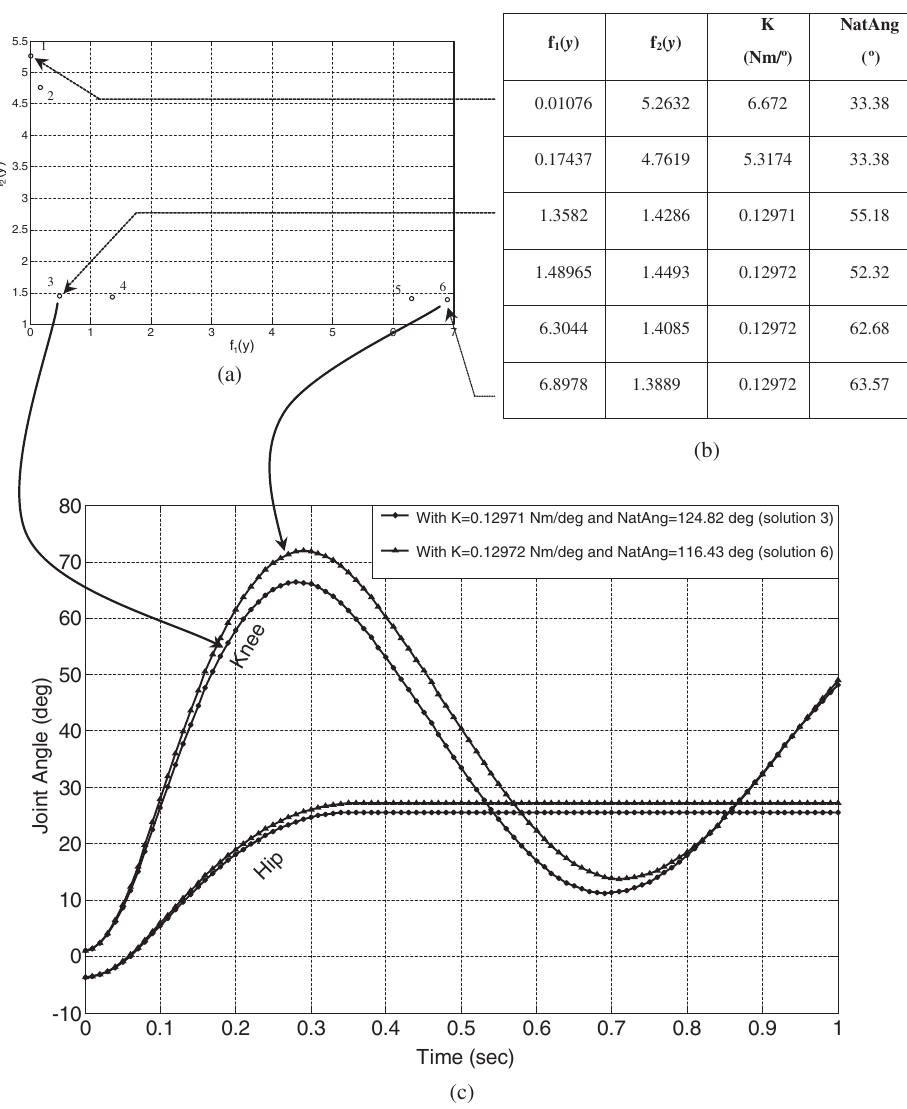
Fig. 9. MOGA optimization (minimization problem) of spring parameters (a) Set of Pareto-optimal solutions (b) Table containing the set of Pareto-optimal solutions with the corresponding spring parameter values (c) Limb joint trajectories corresponding to some Pareto-optimal